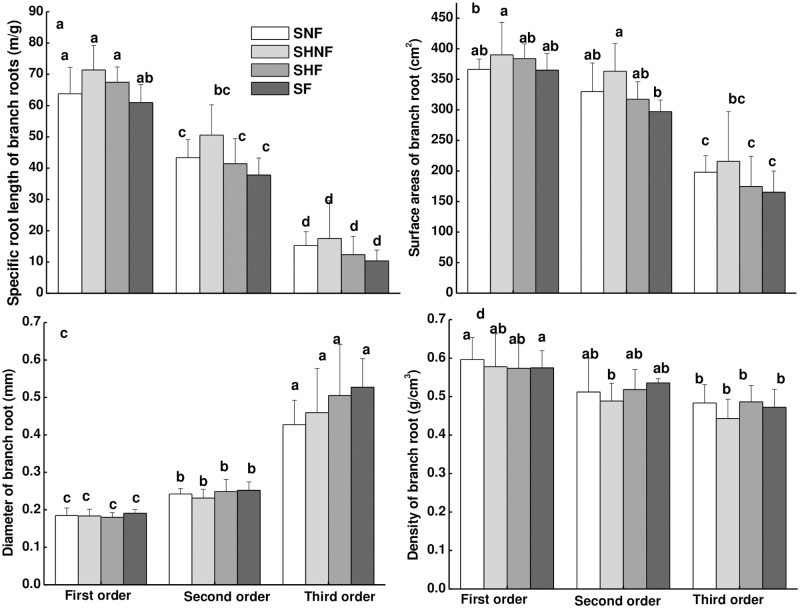
Fine root morphology (SRL (a), SRA (b), Diameter (c), Tissue density (d)) at different branch order affected by nutrient heterogeneity.Different letters indicate significant treatment effect between the means at p<0.05 analyzed by post hoc Tukey’s HSD test (means ± SE, n = 8).